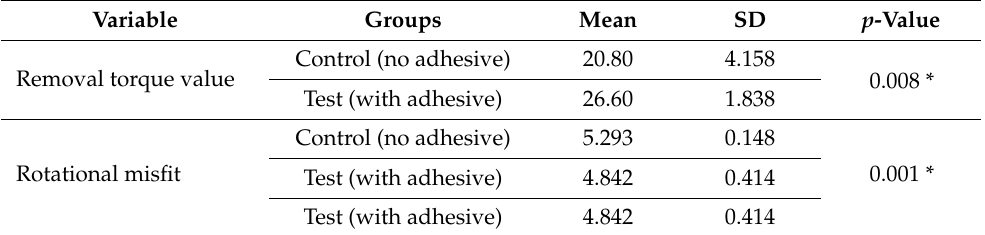
Table 1. Measurements of removal torque value (N · cm) and rotational misfit (degree) at the implant– abutment interface in the test and control groups ( n = 10).